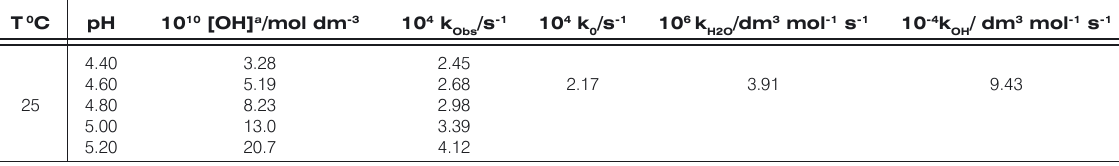
Figure 6. Kinetic plot of k versus the hydroxide ion concentration Obs. for the hydrolysis of hydrolysis of coordinated glycine methyl ester at 25 o C. in aqueous solution 3